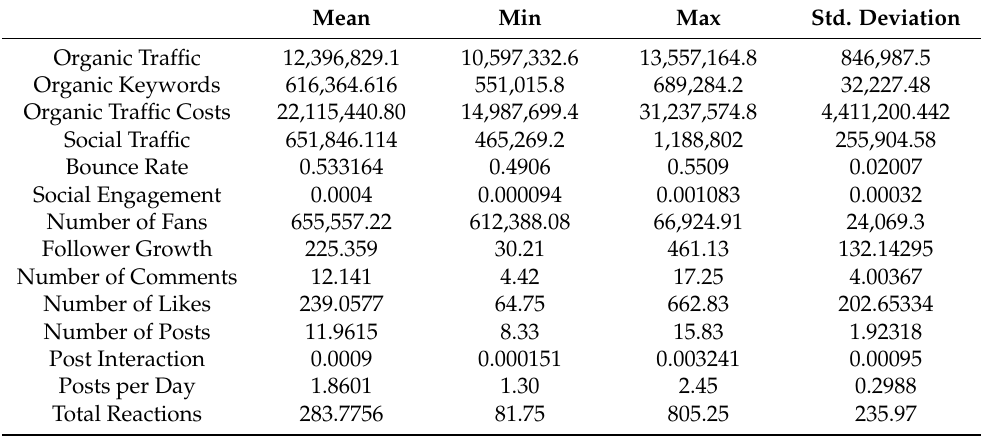
Table 2. Descriptive statistics of 5 CPN firms’ websites during a six-month period. Mean Min Max Std.